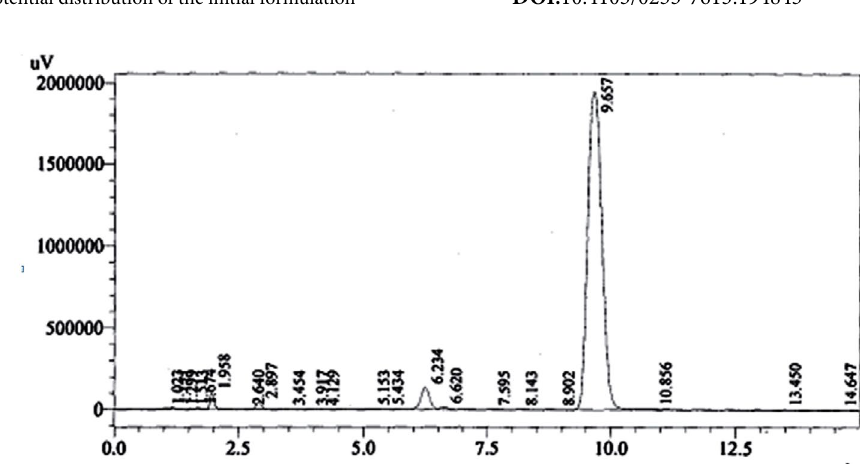
Figure 5. HPLC analysis for assay of the initial